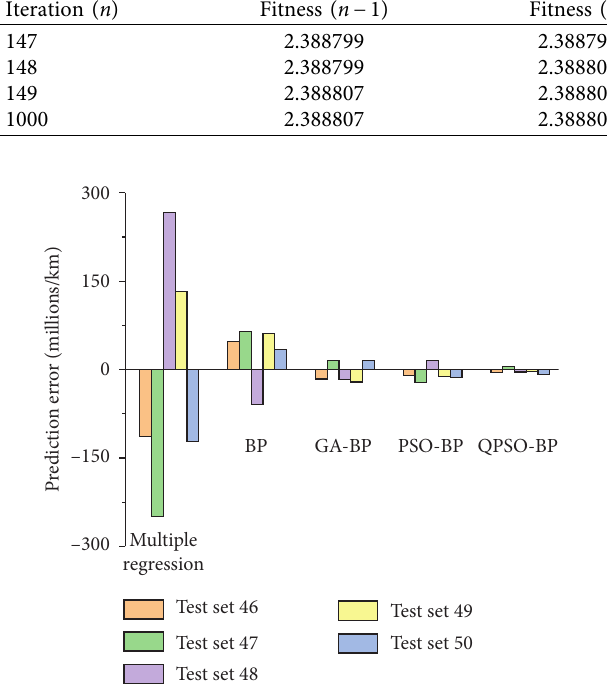
Figure 4: The predicted errors of different algorithms.